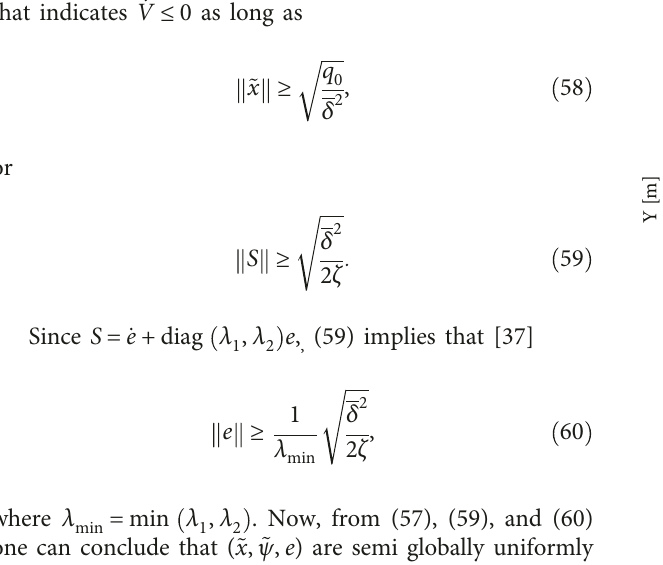
Figure 10: Comparing the observer-based SMC performance with the SMC and feedback linearization controllers in the X – Y